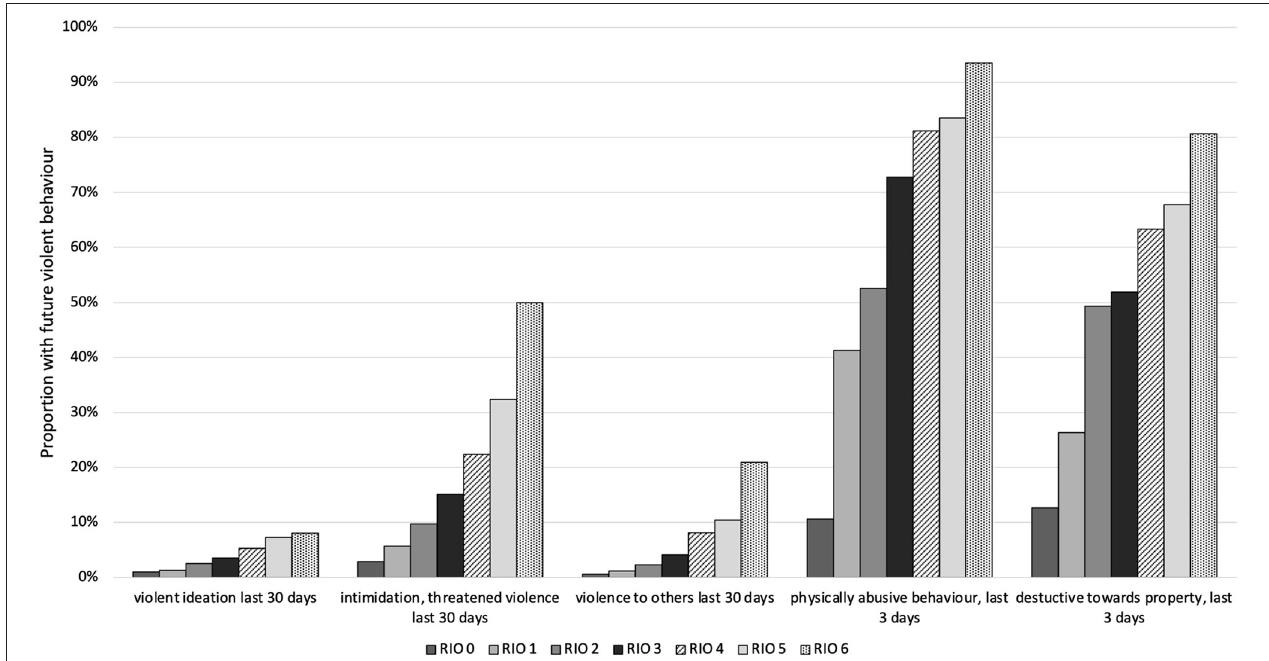
FIGURE 3 | Longitudinal analysis: High risk for future violent behaviour by Risk of Injury to Others (RIO) score at baseline ( N =